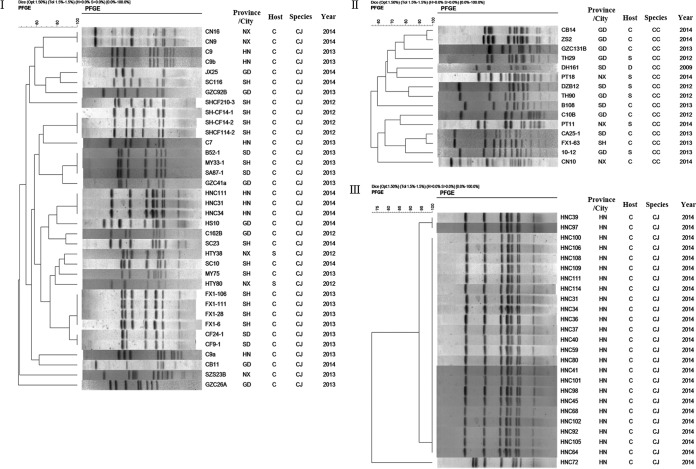
PFGE analysis of representative RE-cmeABC-positive Campylobacter isolates. SmaI was used for digestion. The regions of isolation (provinces and cities) include Guangdong (GD), Shandong (SD), Ningxia (NX), Henan (HN), and Shanghai (SH). The host species include chickens (C), swine (S), and ducks (D). (I) Representative RE-cmeABC-positive C. jejuni (CJ) isolates (n = 36). With 80% genetic similarity as a cutoff, the C. jejuni isolates were grouped into 17 clusters (PFGE patterns represented by multiple strains) and 24 unique PFGE patterns. (II) Representative RE-cmeABC-positive C. coli (CC) isolates (n = 15). C. coli isolates were grouped into 11 clusters and 15 unique PFGE patterns. (III) Representative RE-cmeABC-positive C. jejuni isolates from Henan Province in 2014 (n = 25). The isolates were grouped into two clusters and three unique PFGE patterns.